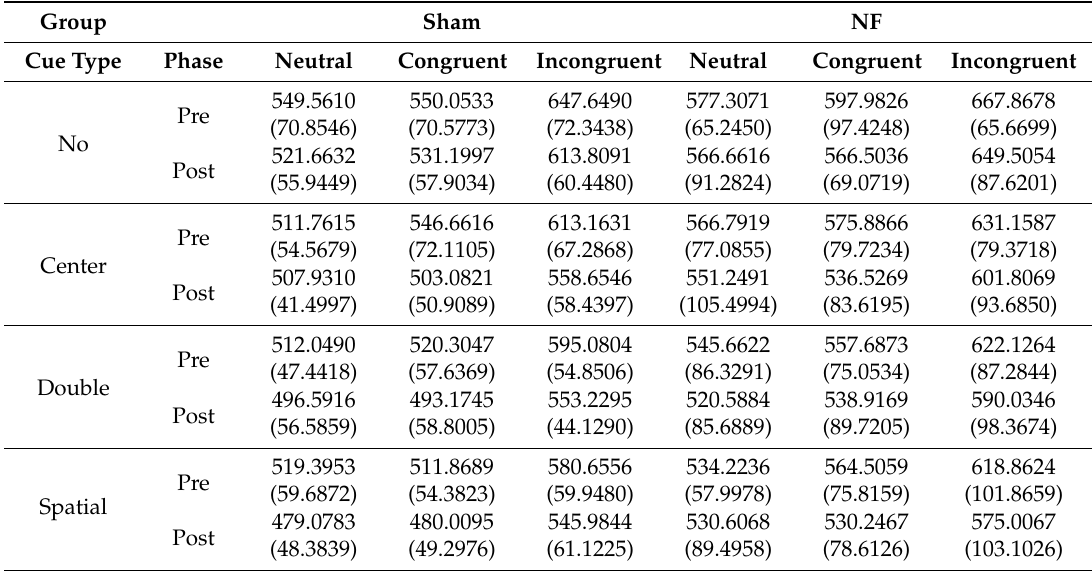
Table 4. Mean accuracies (standard deviations) according to cue and flanker types for each group. Group